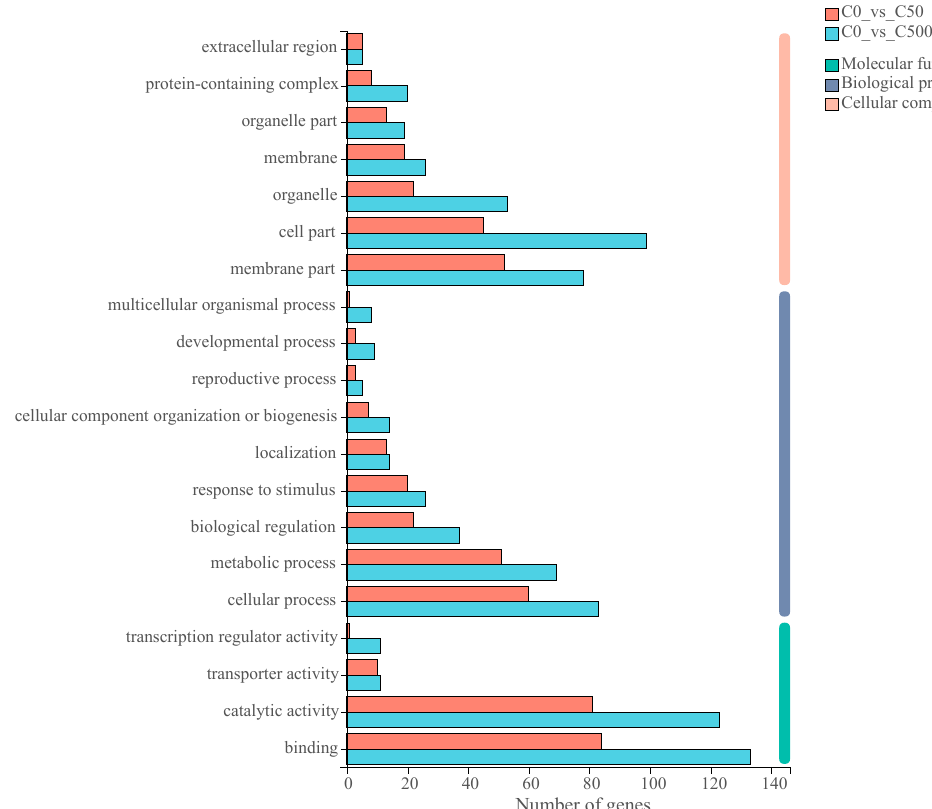
Figure 5. GO function classification of the specific expressed genes under Cd stress.